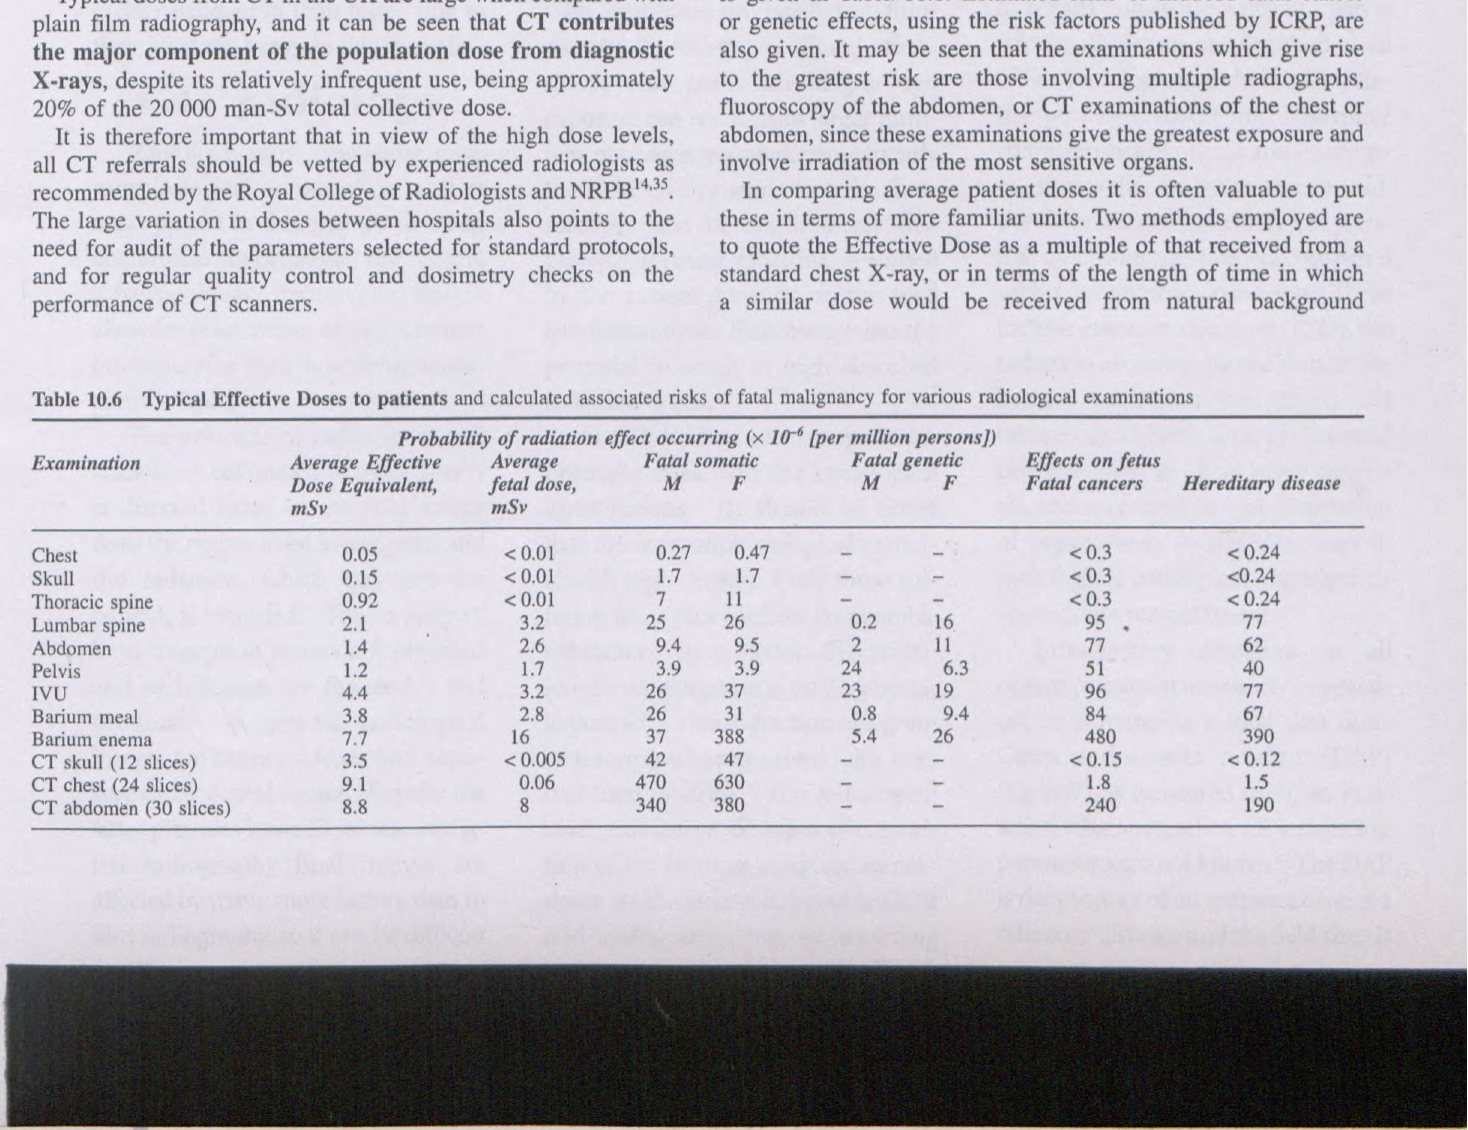
Table 10.6 Typical Effective Doses to patients and calculated associated risks of fatal malignancy for various radiological